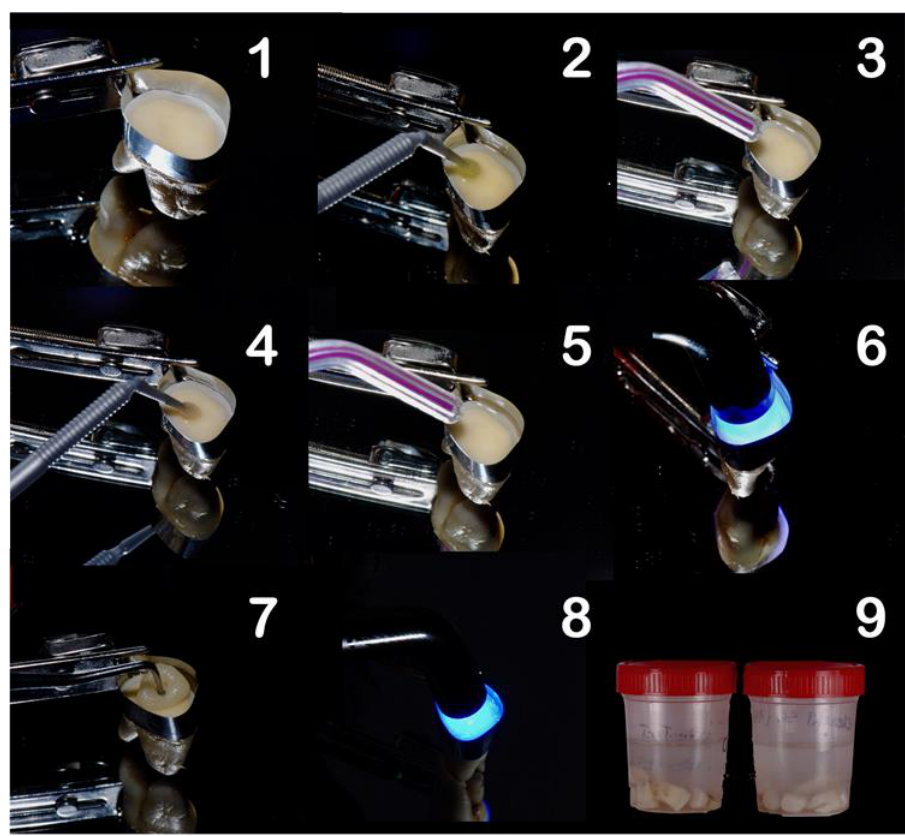
Figure 1. Restorative procedure of the experimental groups, where: (1) application of matrix band, (2) application of the primer, (3) drying step, (4) application of the bond (adhesive), (5) air thinning, (6) light-curing, (7) composite build-up, (8) light-curing in 2 mm increments, and (9) storage of the specimens.